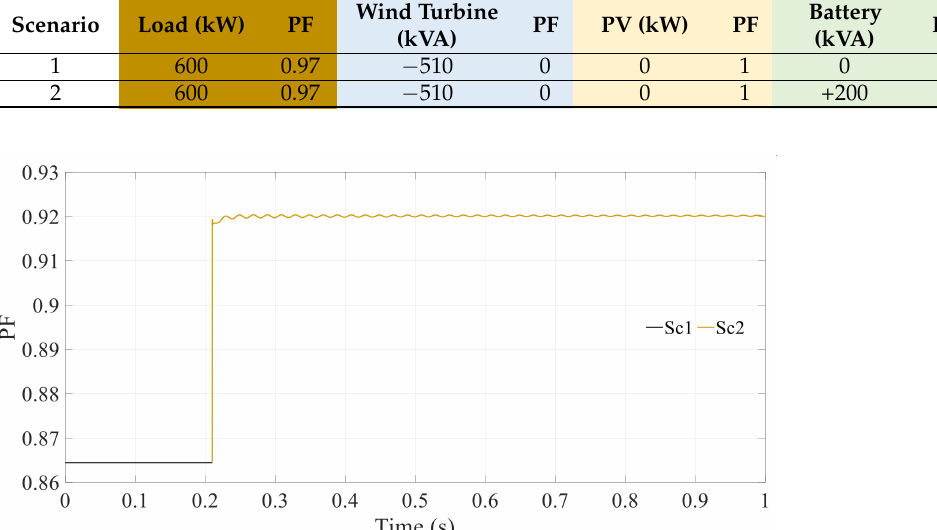
Table 6. Test set points for the use case 4.